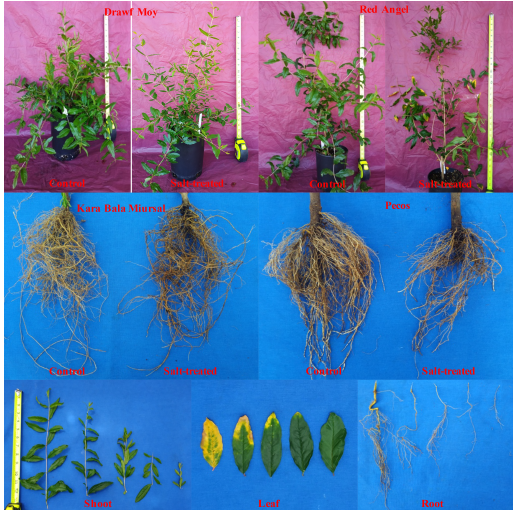
Figure 1. The images of shoots and roots of pomegranate plants in control and NaCl-treated groups. The images of multiple shoots, leaves, and roots showed the standards of measurements—new shoots (length ≥ 3 cm), foliar damage (3 leaves on the left with significant yellowing), and the number of roots (diameter ≥ 1